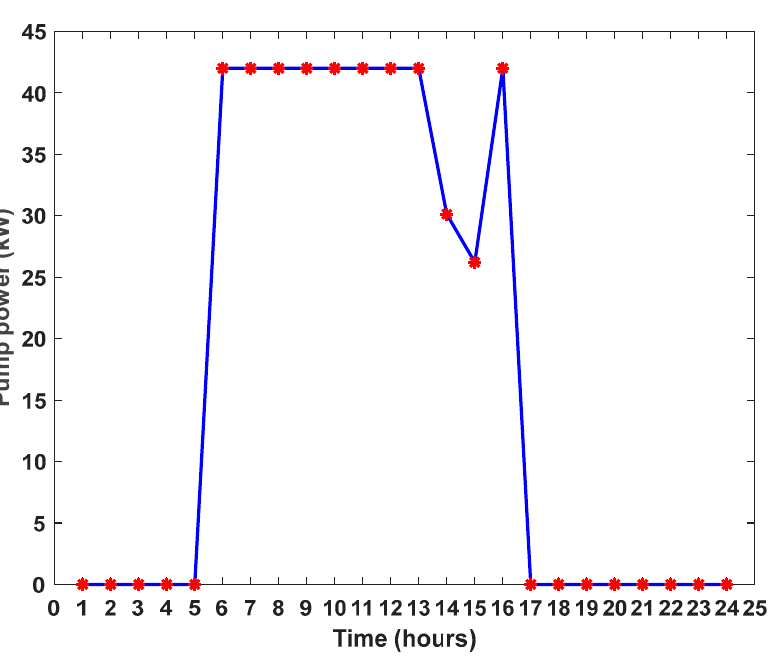
Figure 10. Daily profile of the pump power demand for the month of March.